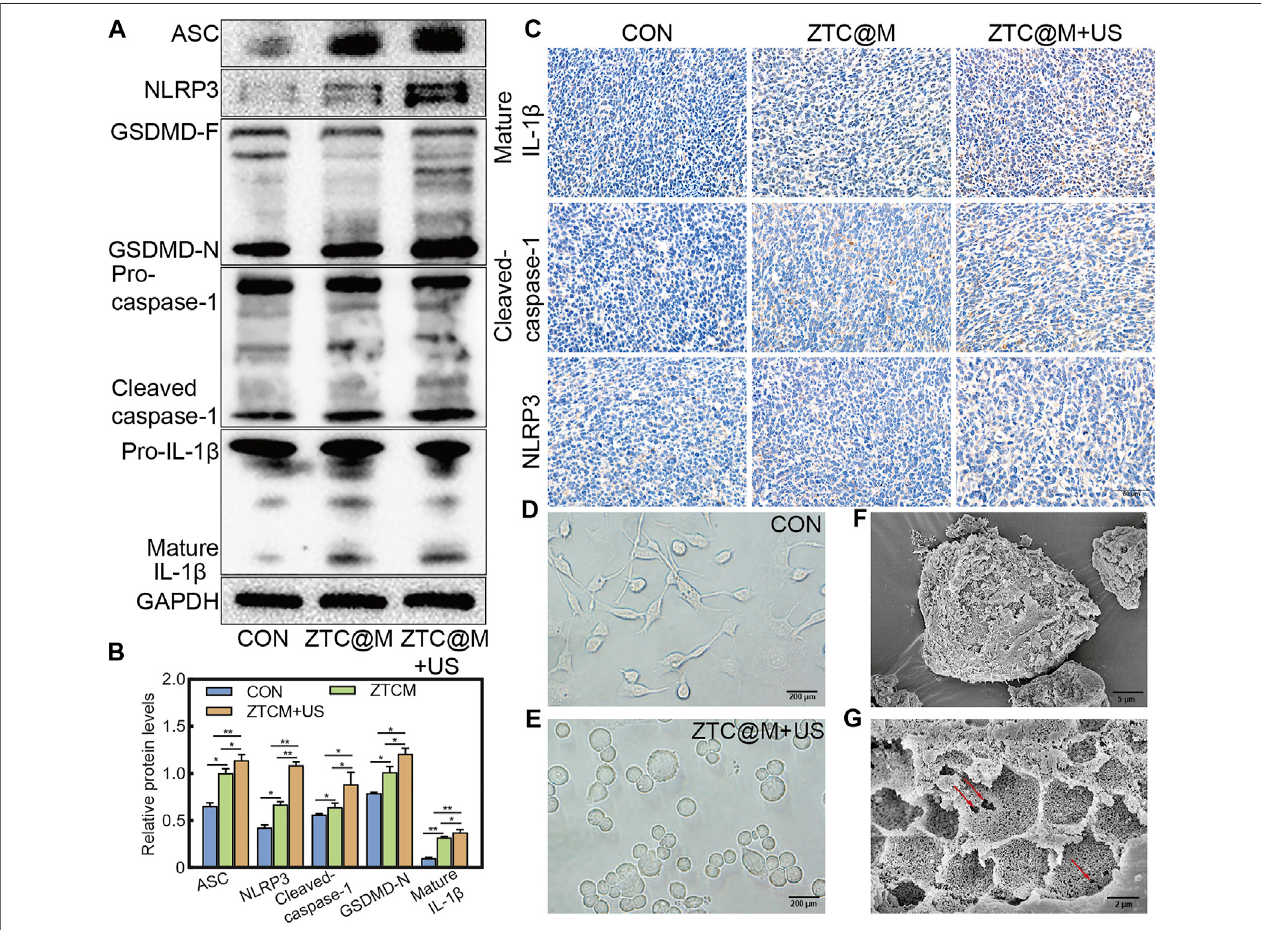
FIGURE 9 | ZTC@M + US activates morphological and molecular characteristics of pyroptosis. The protein levels of cleaved-caspase-1, ASC, GSDMD-N, mature IL-1 β , and NLRP3 after SDT (A) . The bar chart indicates the relative density of cleaved-caspase-1, ASC, GSDMD-N, mature IL-1 β , and NLRP3 to GAPDH in A (B) . IHC staining of cleaved-caspase-1, mature IL-1 β , and NLRP3 of tumor (C) . Phase-contrast photomicrographs showing AGS cells untreated (D) and treated with ZTC@M + US (E) (100×). Scanning electron micrographs of AGS cells after treatment with ZTC@M + US (F) and (G) . Scale bars are 5 µm (E) and 2 µm (F) . * p < 0.05, ** p <